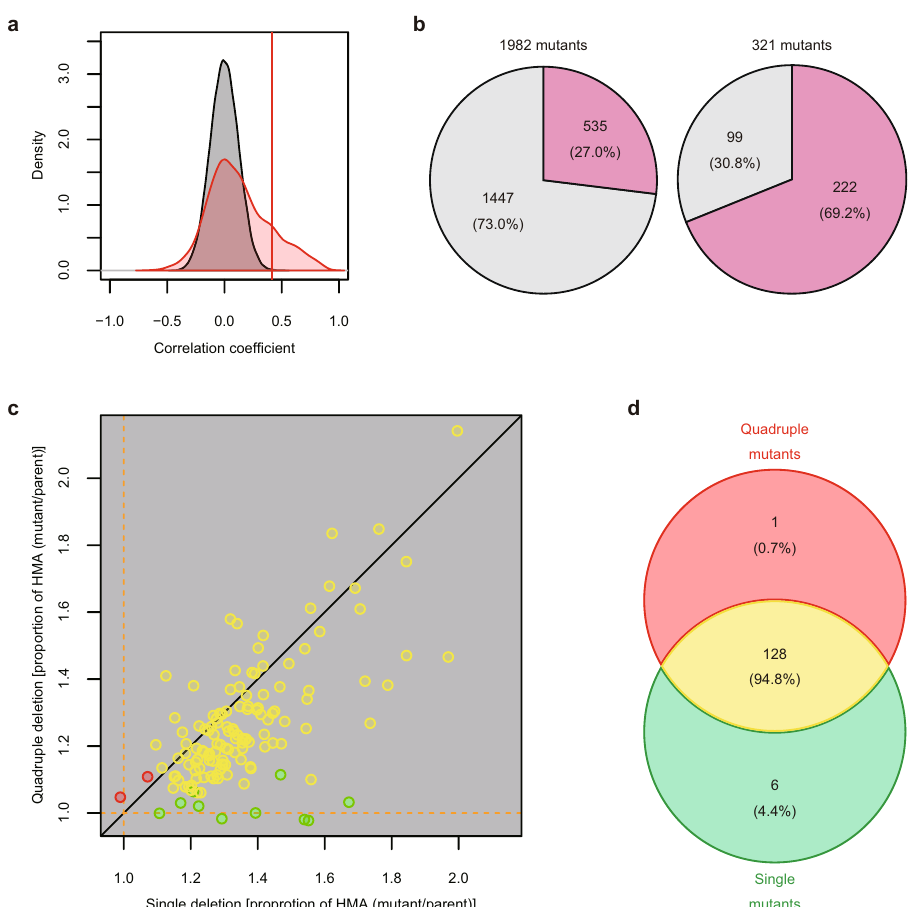
Fig. 5 Reproducibility of morphological phenotypes. a Distribution of correlation coef fi cients between quadruple mutants and single mutants. Correlation coef fi cients were calculated between each pair of the 1982 deletion mutants in quadruple mutants and single mutants (red) and between arbitrary pairs of 3 Δ ( n = 749) and his3 Δ ( n = 109) (grey), and are expressed using density plots. Vertical red lines indicate a threshold at FDR = 0.05 by the one-tailed t-distribution test. b Percentages of gene-deletion mutants showing reproducibility. Among 1982 common gene-deleted strains (left), 27.0% were detected as having signi fi cantly similar morphological phenotypes (FDR = 0.05 by the one- tailed t-distribution test) between single and quadruple mutants. Among 321 quadruple mutants with signi fi cantly high HMA, 69.2% were detected as having signi fi cant phenotypic similarity (FDR = 0.05 by the one-tailed t-distribution test). c Comparison of average HMA in the genes belonging to the same gene function groups. Orange dashed lines indicate averages of the parental strains. Black line indicates the same HMA between quadruple and single mutants. Green and red circles indicate the gene groups with signi fi cantly high average HMA in the single- and quadruple-deletion mutants (Wald test, FDR = 0.05), respectively. Yellow circles indicate the gene groups with similar HMA. d Venn diagram of the gene groups; the color legend is the same as in ( c